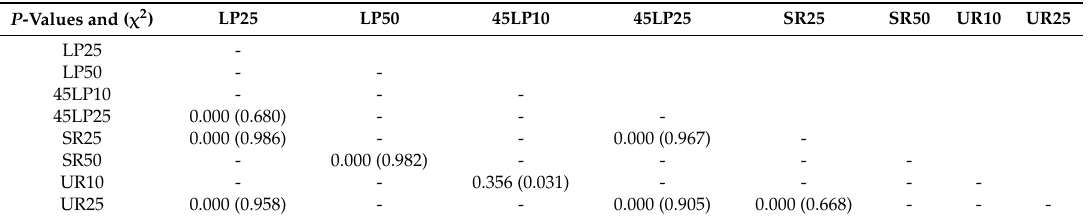
Table A5. P -values and ( χ 2 ) for normalized absolute values of frontal moments over all subjects—was not analysed.